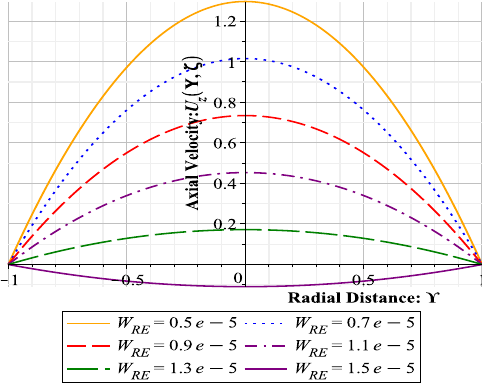
Figure 3. Behavior of U z ( γ , ζ ) with γ at ζ = 0.9 for different values of W RE .